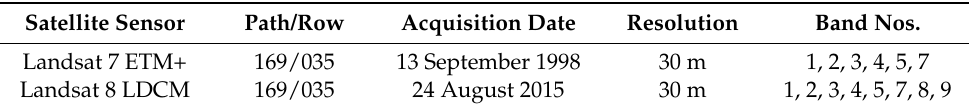
Table 2. Satellite (sub-scene) images used in this study to quantify landscape patterns and land cover